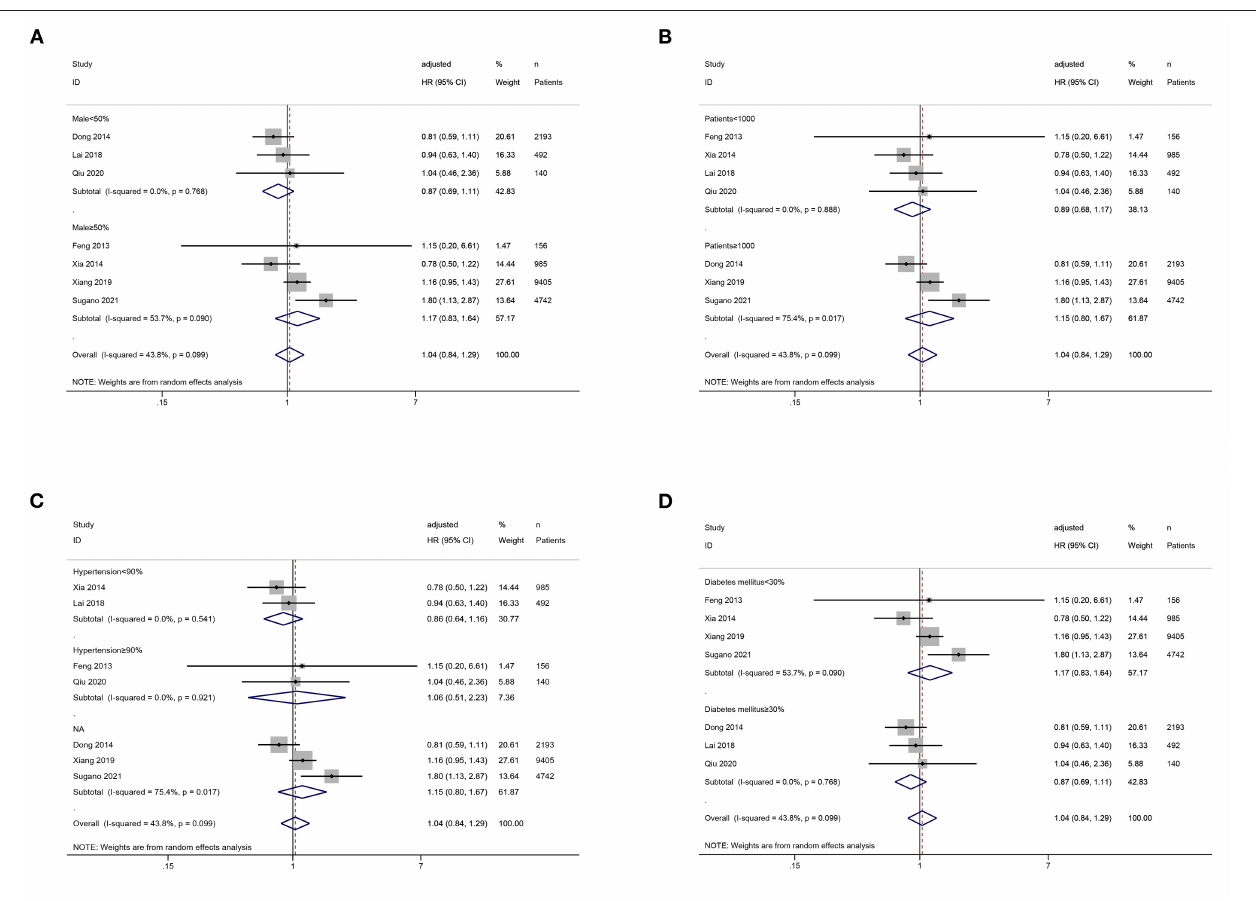
FIGURE 5 | Subgroup analysis of the association between serum uric acid levels (low vs. middle) and all-cause mortality in PD patients. (A) by male proportion (50% as the cut-off value); (B) by sample size (1,000 as the cut-off value); (C) by hypertension proportion (90% as the cut-off value); (D) by diabetes mellitus proportion (30% as the cut-off